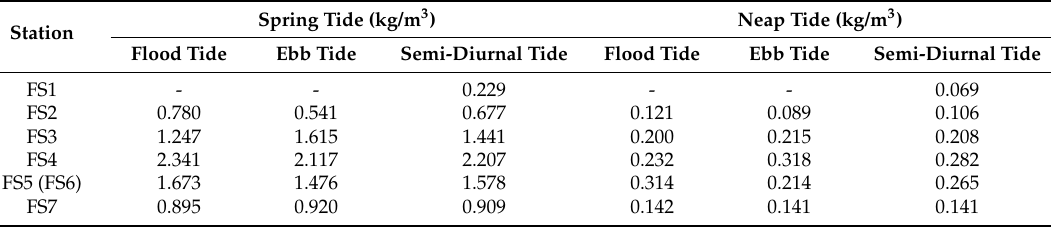
Table 3. Time-averaged mean sediment concentration ( S ) values during the wet season (second half of June